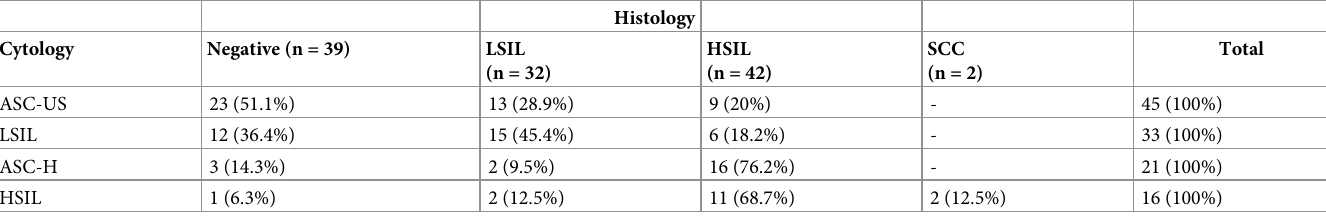
Table 3. The relationship between cytologic results and histologic diagnoses.